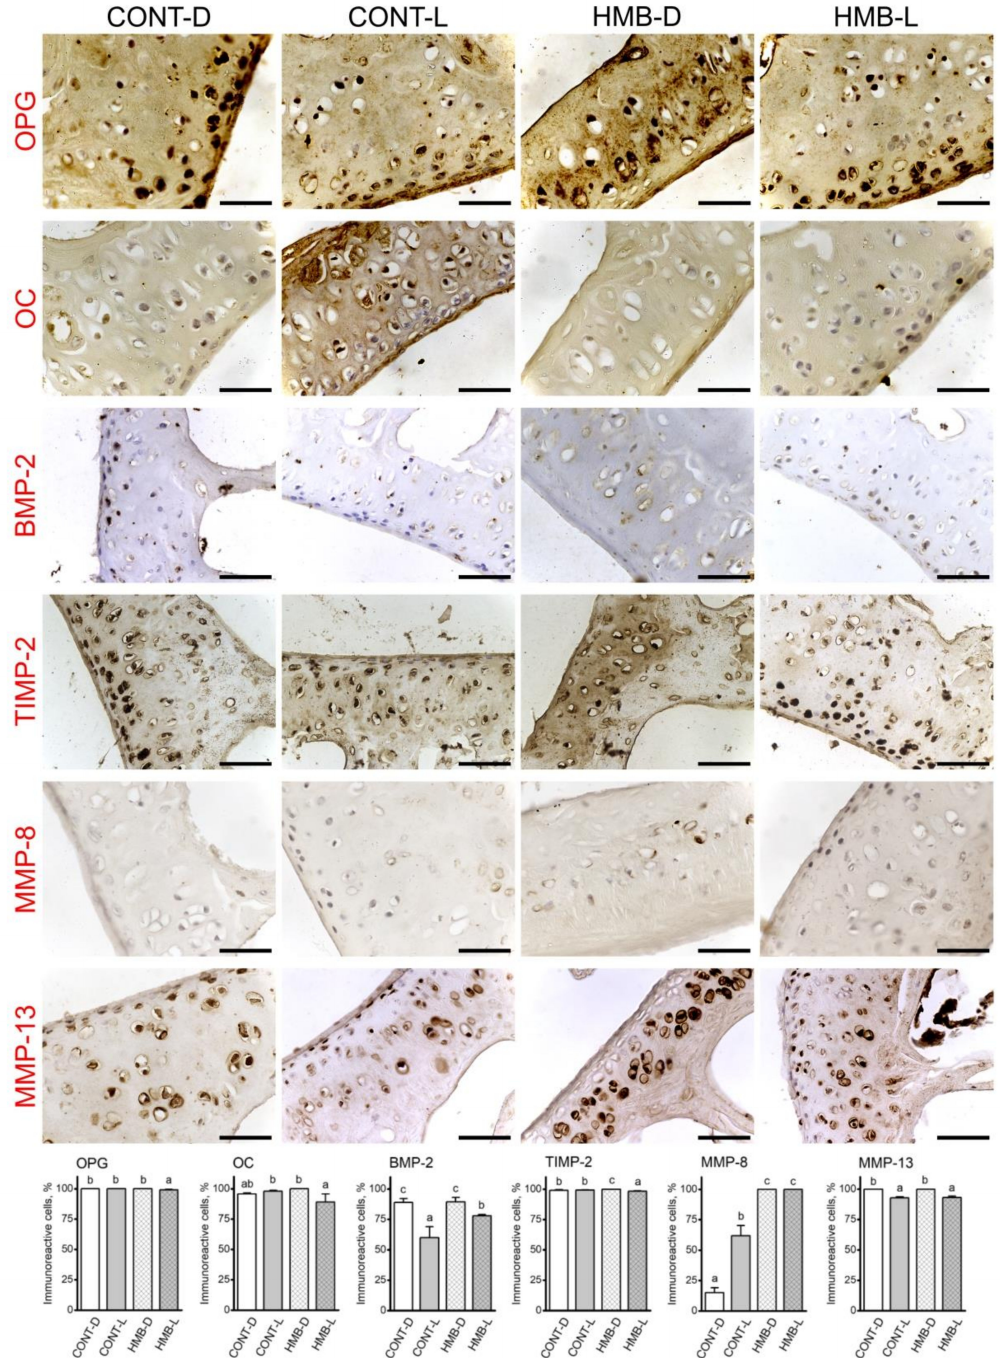
Figure 8. Representative images of the immunohistochemical reactions and the percent of immunoreactive cells for osteoprotegerin (OPG), osteocalcin (OC), bone morphogenetic protein 2 (BMP-2), tissue inhibitor of metalloproteinases 2 (TIMP-2), matrix metalloproteinase 8 (MMP-8) and matrix metalloproteinase 13 (MMP-13) in the articular cartilage of femora from pregnant female controls (not receiving HMB) at delivery (CONT-D) or after the lactation period (CONT-L) and from pregnant HMB females (receiving HMB at a dose of 0.02 g/kg b.w. during the middle trimester of pregnancy) at delivery (HMB-D) or after the lactation period (HMB-L). All the scale bars represent 40 µ m. Bar plots show percentage of immunoreactive chondrocytes in the articular cartilage in each